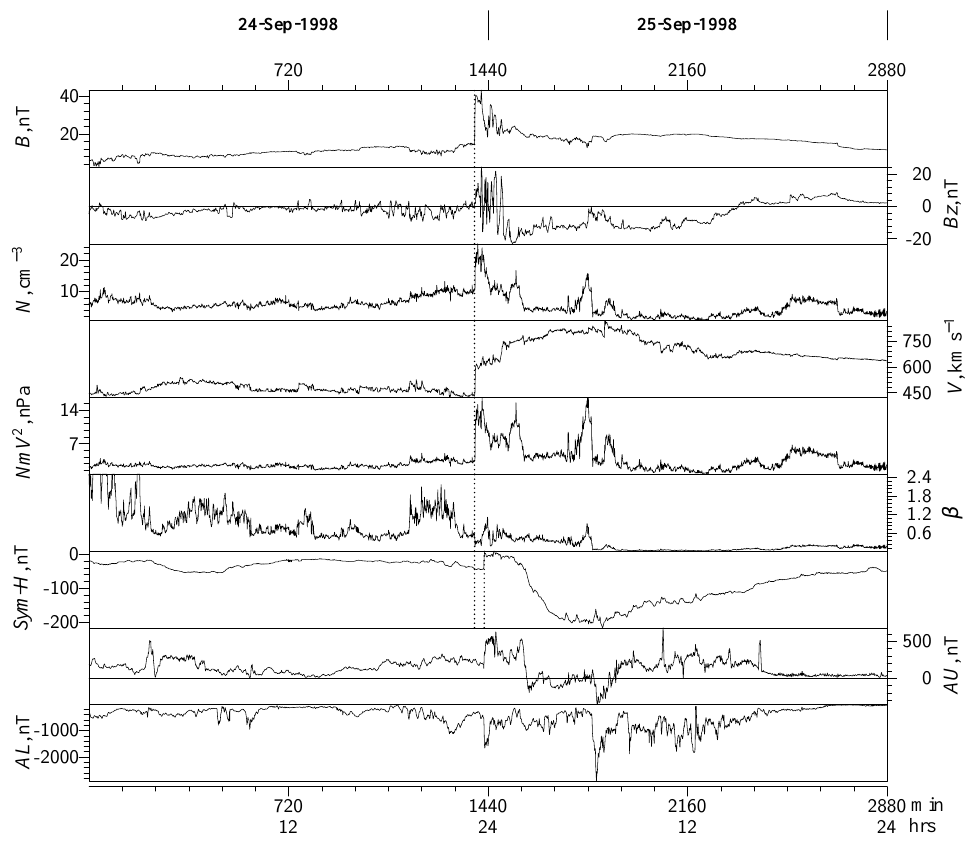
Fig. 1. Solar wind, IMF on board the ACE spacecraft and geomagnetic indices (1-min averages) from top to bottom: IMF intensity B , north-south B z component, solar wind plasma density N and velocity V , solar wind ram pressure P , and plasma β (a ratio of plasma and magnetic pressures), indices Sym-H, AU, and AL on 24–25 September